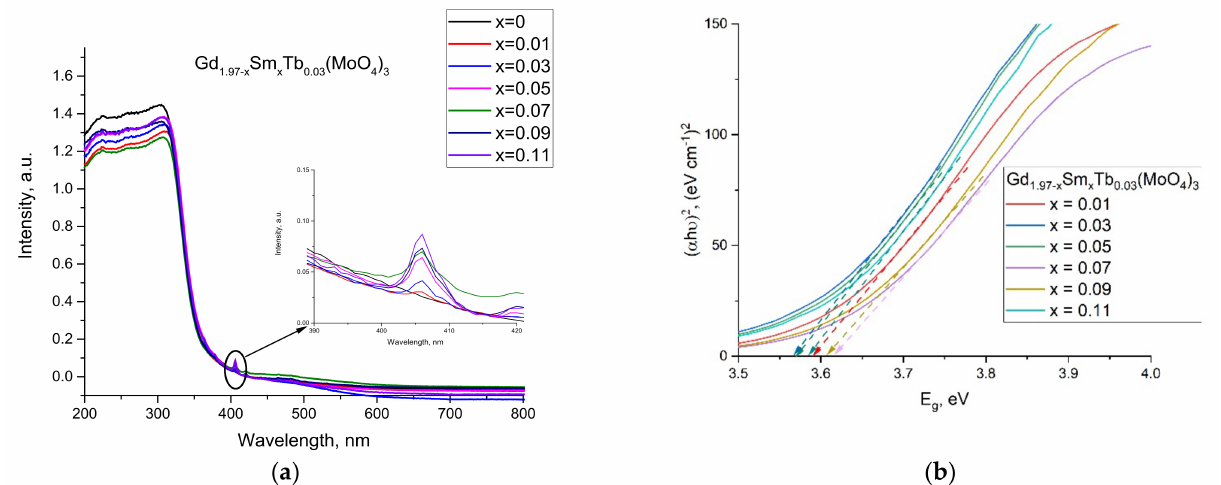
Figure 3. ( a ) UV-Vis spectra of Gd 1.97 − x Sm x Tb 0.03 (MoO 4 ) 3 and ( b ) band gap energy calculated for the samples.